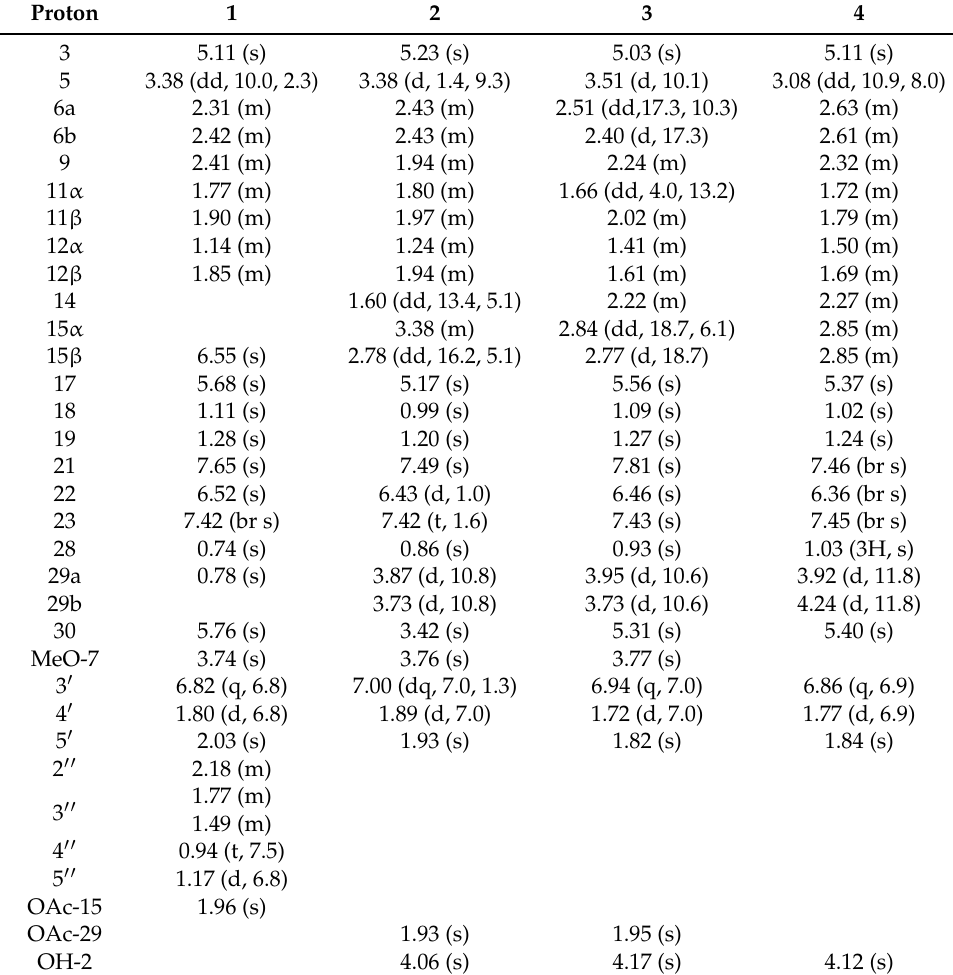
Table 1. 1 H-NMR (500 MHz) data of compounds 1 – 4 (CDCl 3 , δ H in ppm, J in Hz).